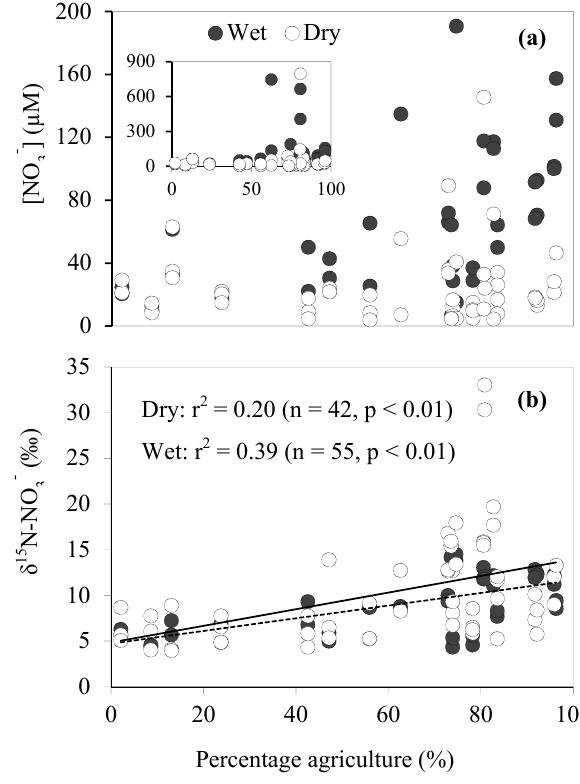
Figure 4. Relationship between (a) NO − NO − and the percentage of agricultural land use. In (b) the solid 3 line represents the relationship between the variables during dry pe- riods; the dotted line represents wet